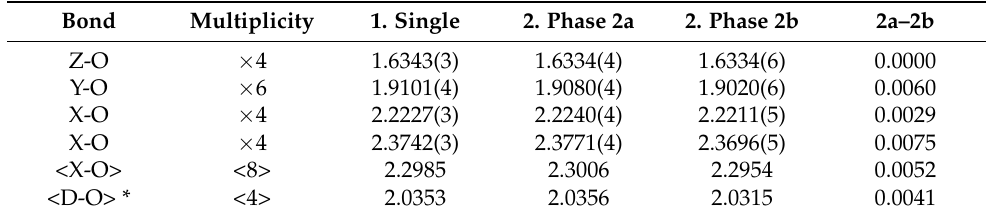
Table 4. Selected distances (Å) and angles ( ◦ ) for two pyrope